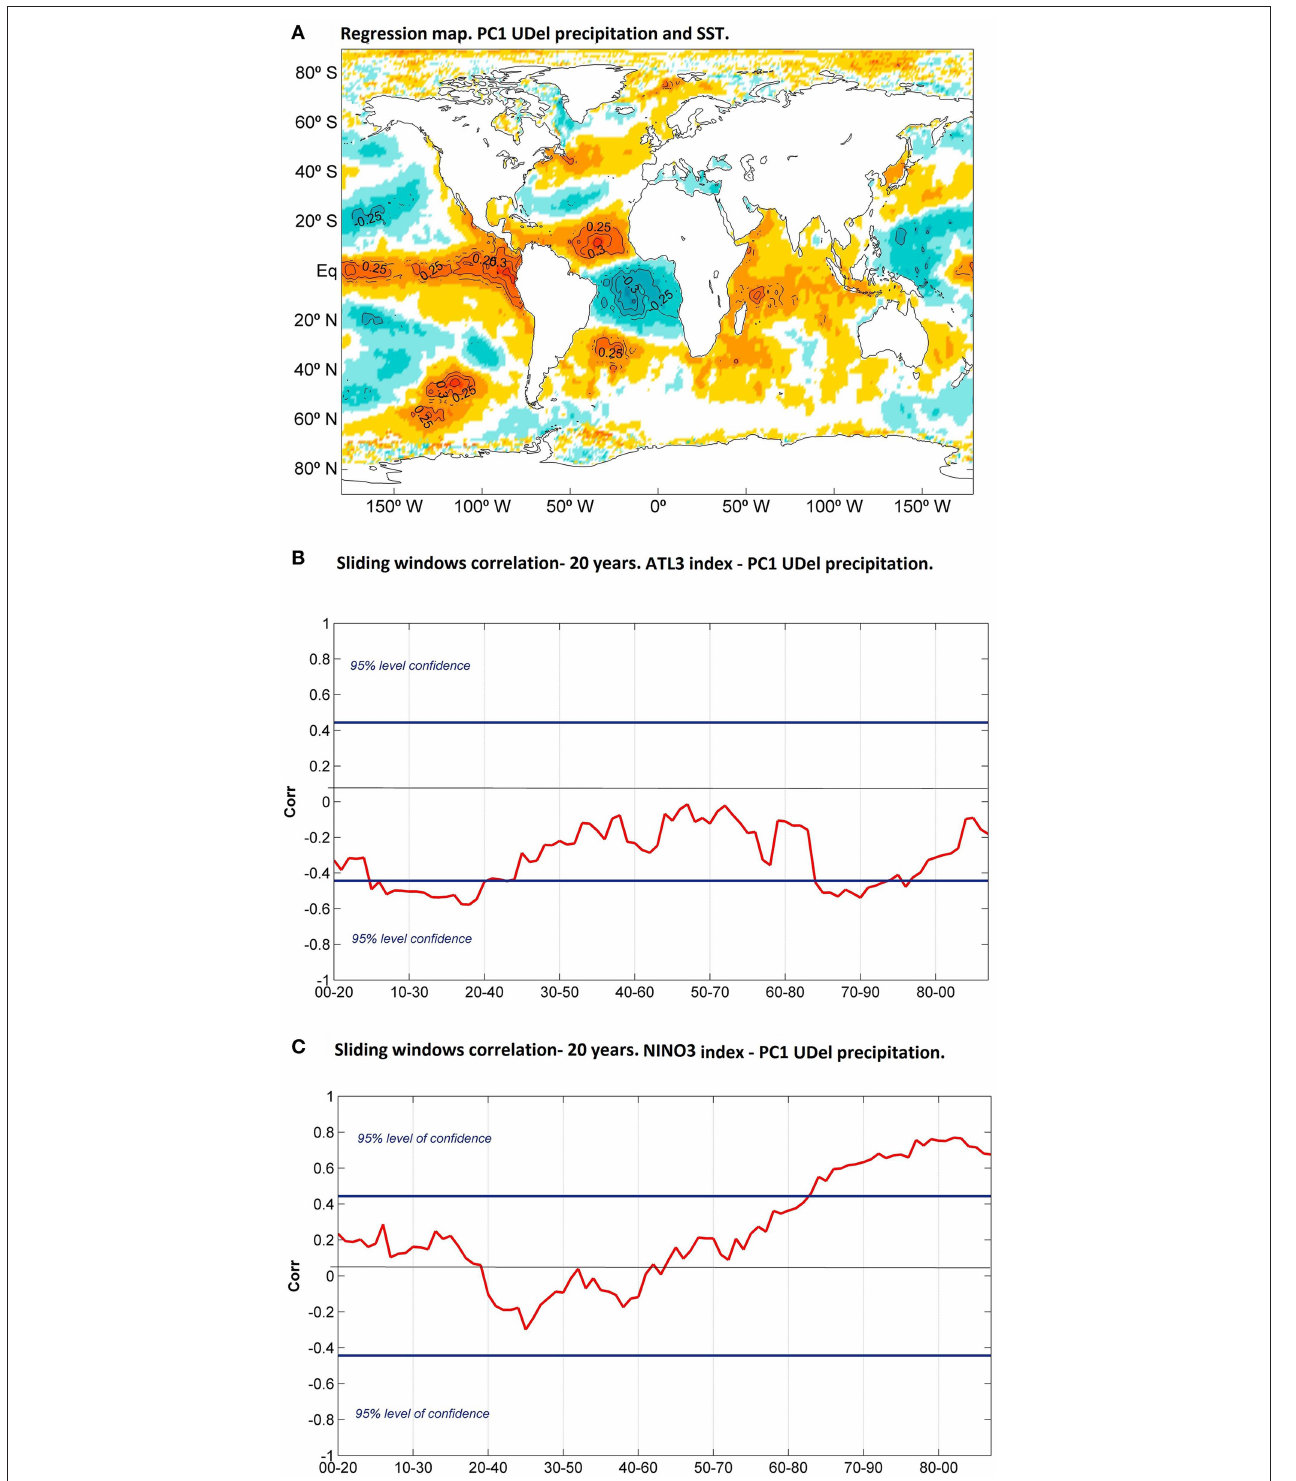
FIGURE 3 | (A) Regression map of anomalous SST onto the PC1 ( ◦ C/std in the PC) obtained for UDel dataset. The regions with correlations significant at the 95% level are contoured. (B) Twenty year moving window correlation between the standardized PC1 associated with the leading mode computed UDel and the ATL3 index (red line). In the horizontal axis, the year in which the period of 20 year starts is represented. (C) Twenty year moving window correlation between the standardized PC1 associated with the leading mode computed UDel and the NINO3 index (red line). In the horizontal axis, the year in which the period of 20 year starts is represented. The dark blue lines show the thresholds over which correlations are significant at 95% confidence level.